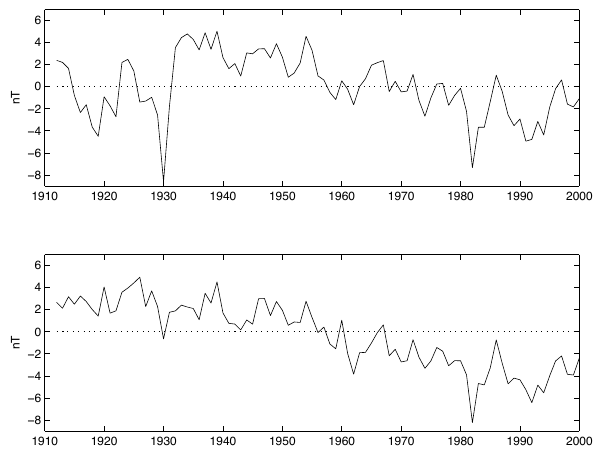
Fig. 8. Difference in 1912–2000 between the reconstructed and original aa index. Top: using uncorrected ESK IHV indices; Bot- tom: using corrected ESK IHV